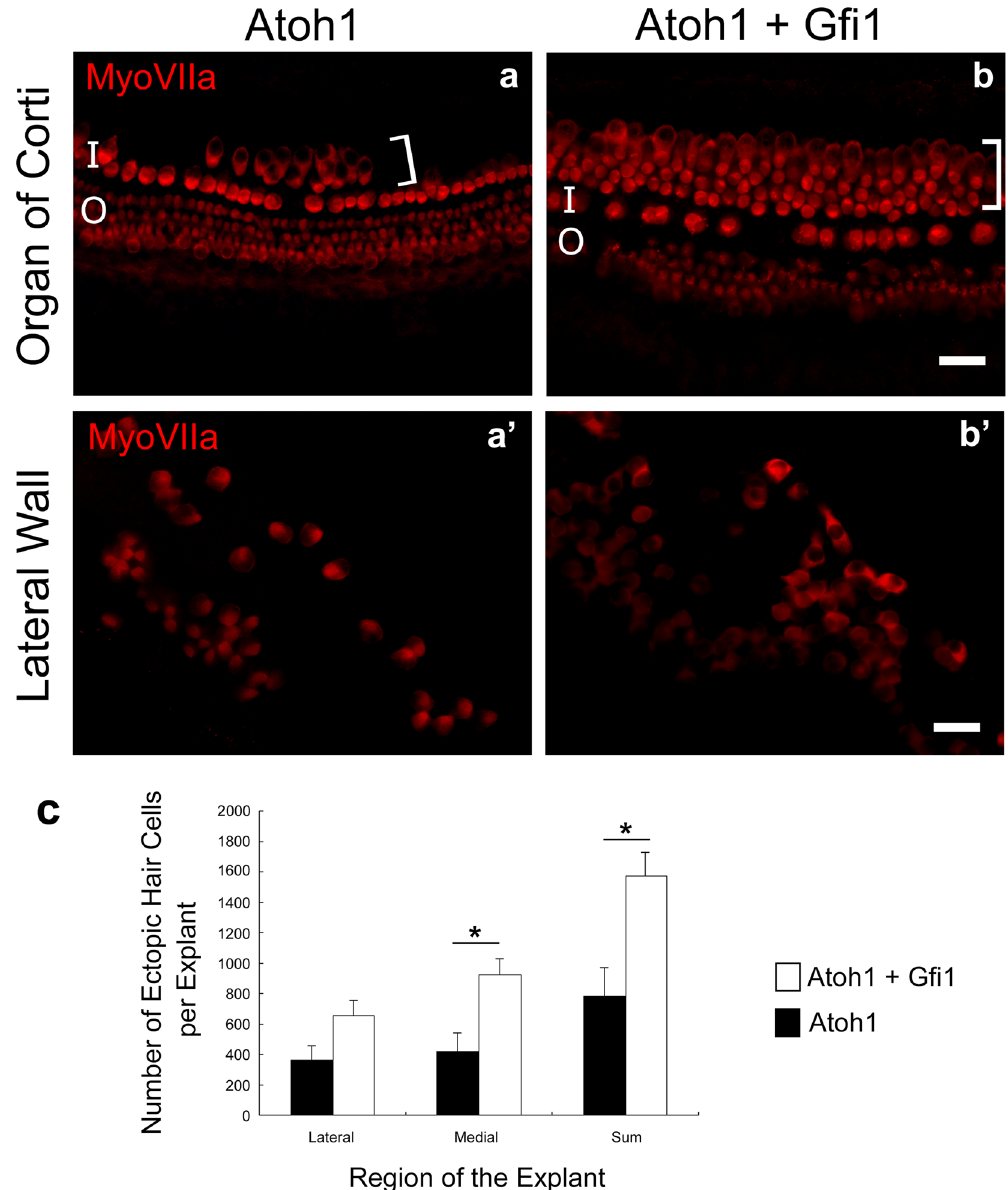
Figure 1. Gfi1 enhances Atoh1 -induced ectopic hair cell generation in neonatal cochlear explant cultures. Whole mounts of cultured explants stained for myosin VIIa photographed with epi-fluorescence showing the OC and adjacent areas ( a , b ) and lateral wall ( a ′ , b ′ ). Ectopic HCs (bracket) were induced on the medial side of the inner HC area by Atoh1 treatment ( a ). Larger numbers of ectopic HCs were observed after Atoh1 + Gfi1 treatment ( b ). Ectopic HC induction in the lateral area was evident in Atoh1 ( a ′ ) and Atoh1 + Gfi1 treatment ( b ′ ). Statistical analysis showed significantly more ectopic Myosin VIIa positive cells in the region medial to the OC after Atoh1 + Gfi1 treatment than after Atoh1 alone ( c ). I inner HC area, O outer HC area, Brackets ectopic HC. Scale bars represent 30 μm. Error bars are ± SD. Differences between groups were assessed via Student’s t test; (*) indicates p <